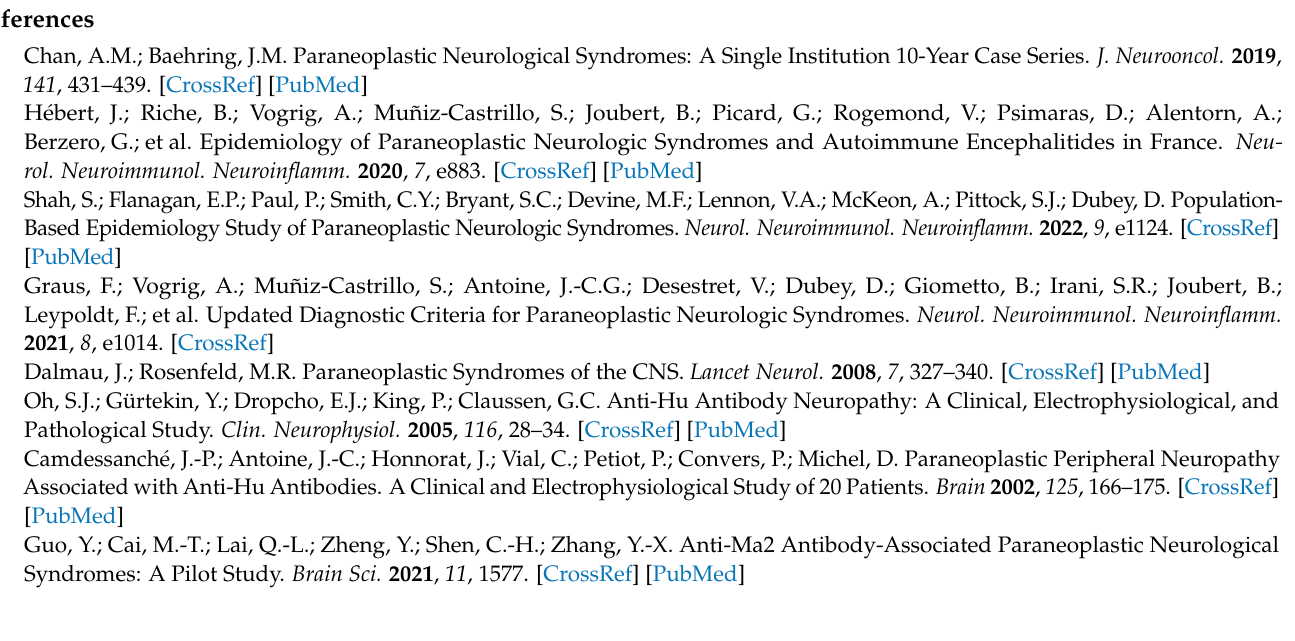
Table S4: Comparison between subacute sensory neuropathy and other